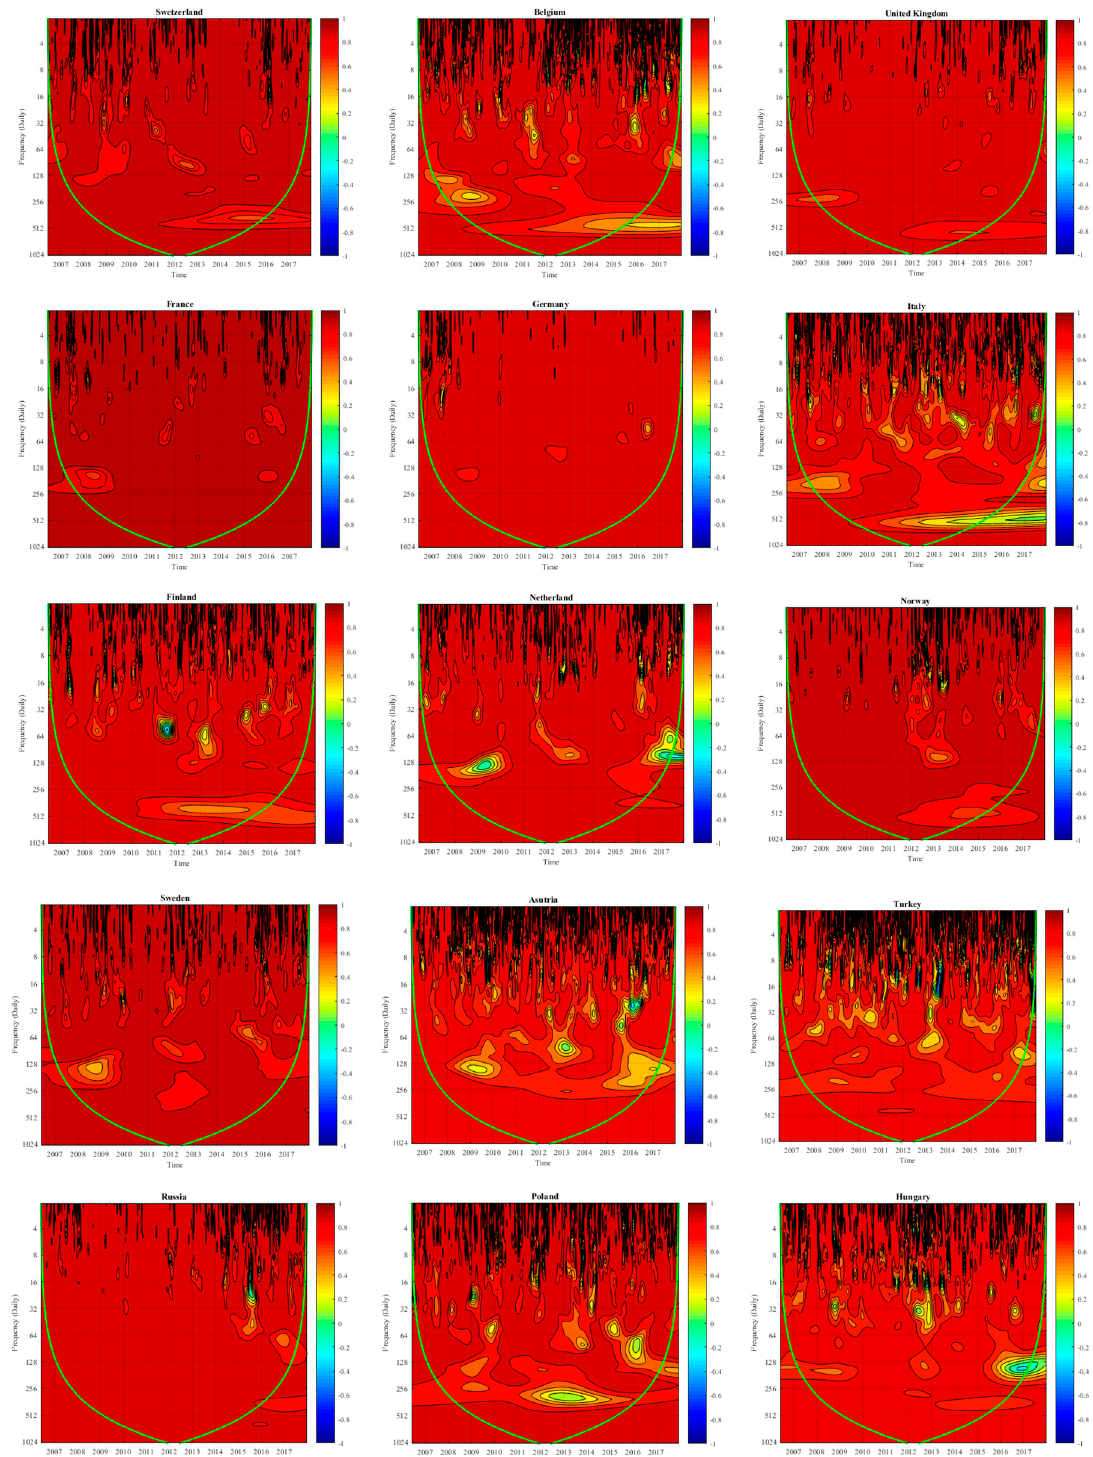
Figure A2. Islamic-conventional stock returns Wavelet correlations for European region’s markets.